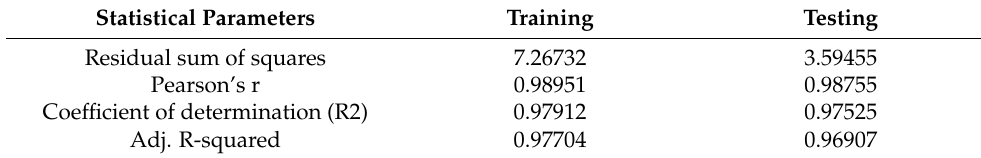
Table 3. The statistical report of the linear regression in the training and testing phases (height). Statistical